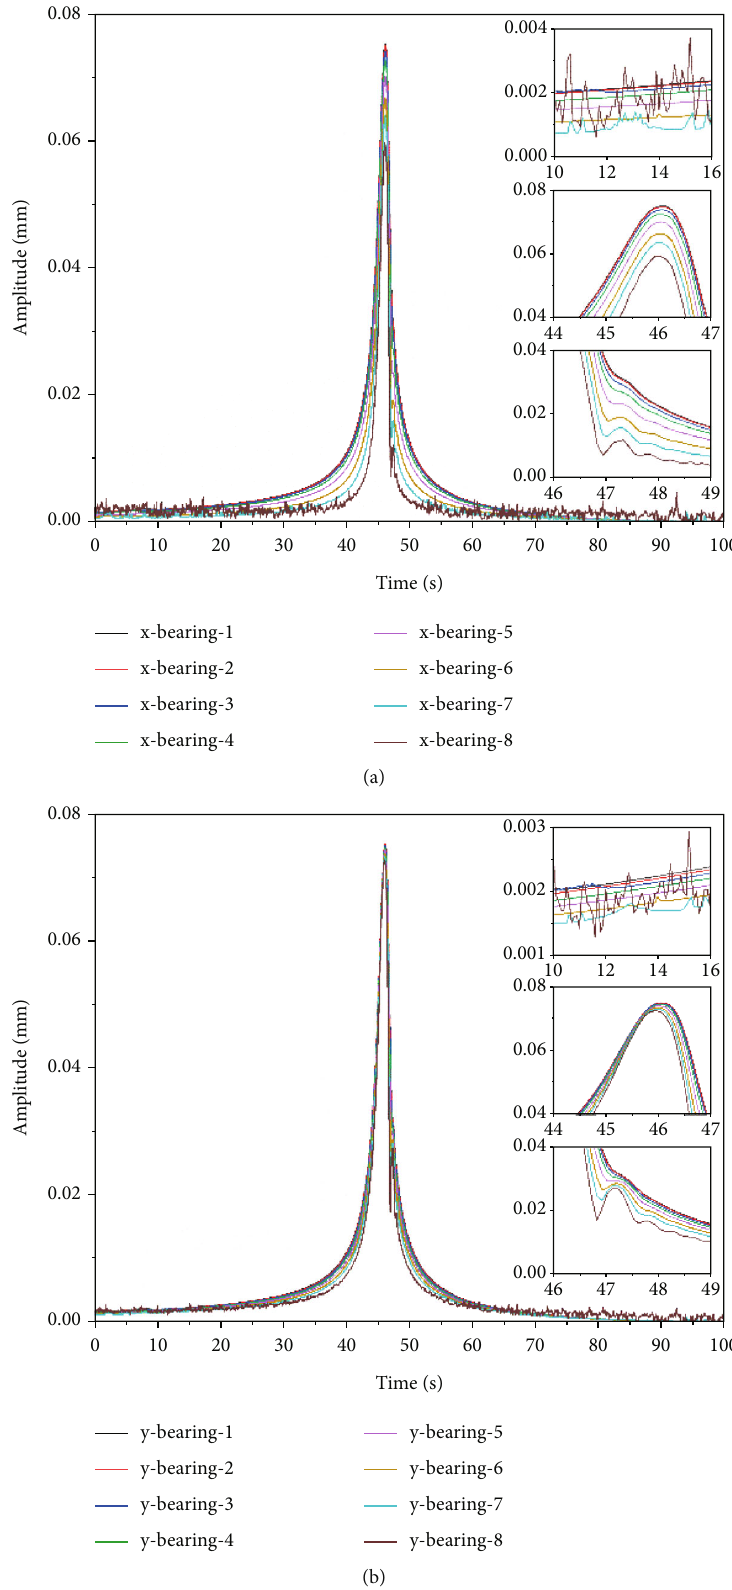
Figure 22: Variations of the node displacements at the rear bearing during run-down process. (a) Response in the x -axis direction. (b) Response in the y -axis